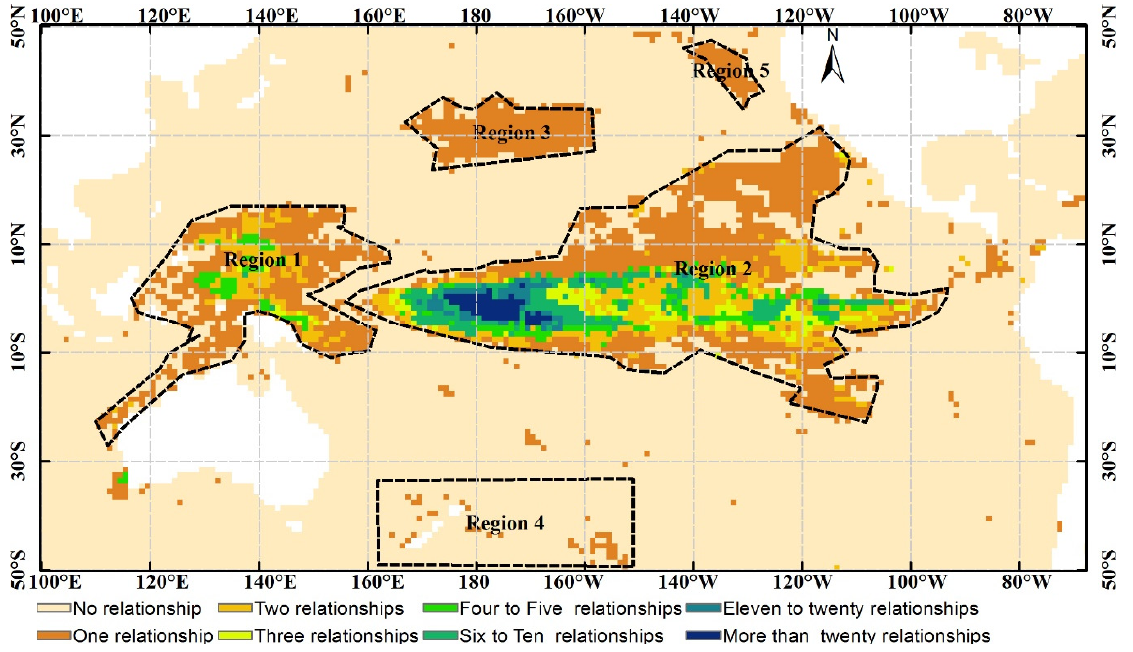
Figure 2. Five more interactive regions among marine environments and ENSO in the Pacific Ocean (PO).